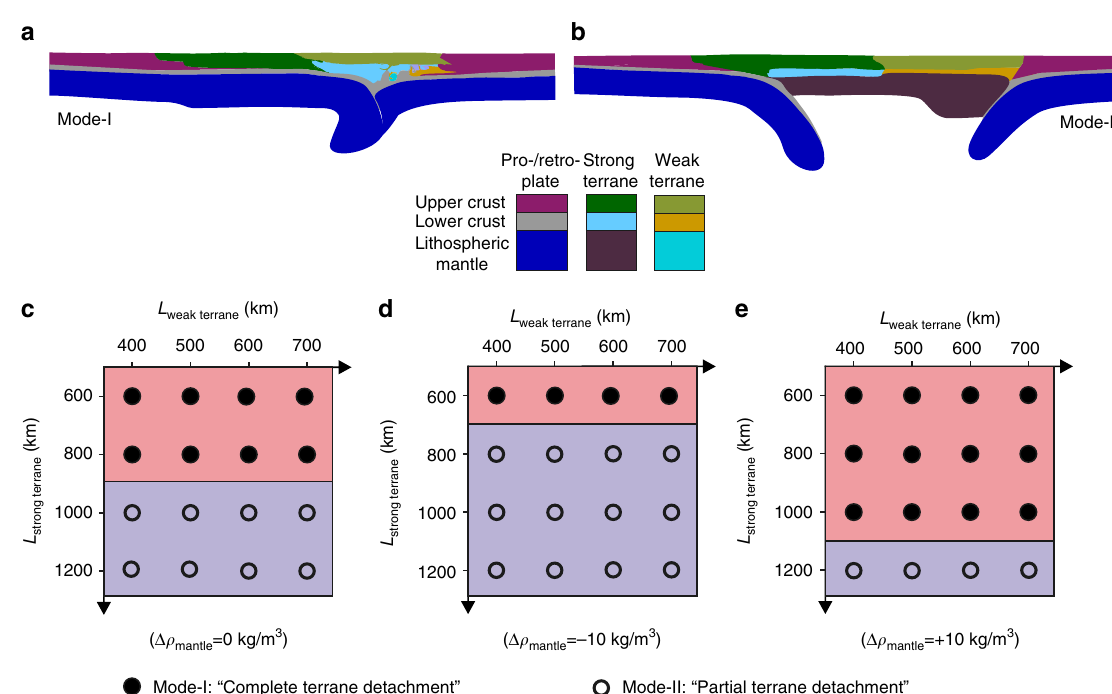
Fig. 5 Phase diagram of the contrasting detachment modes. a Mode-I of complete terrane detachment, in which the lithospheric mantles of both the strong and weak terranes are detached during collision. b Mode-II of partial terrane detachment, in which only the weak terrane is detached, whereas the strong terrane is strongly deformed but not detached. c Regime diagram with the same reference density (i.e., at the same pressure and temperature) of the terrane lithospheric mantle and the asthenosphere. d Regime diagram with the reference density of lithospheric mantle of both terranes decreased to be − 10 kg m − 3 lower than the asthenosphere. e Regime diagram with the reference density of lithospheric mantle of both terranes increased to be + 10 kg m − 3 higher than the asthenosphere